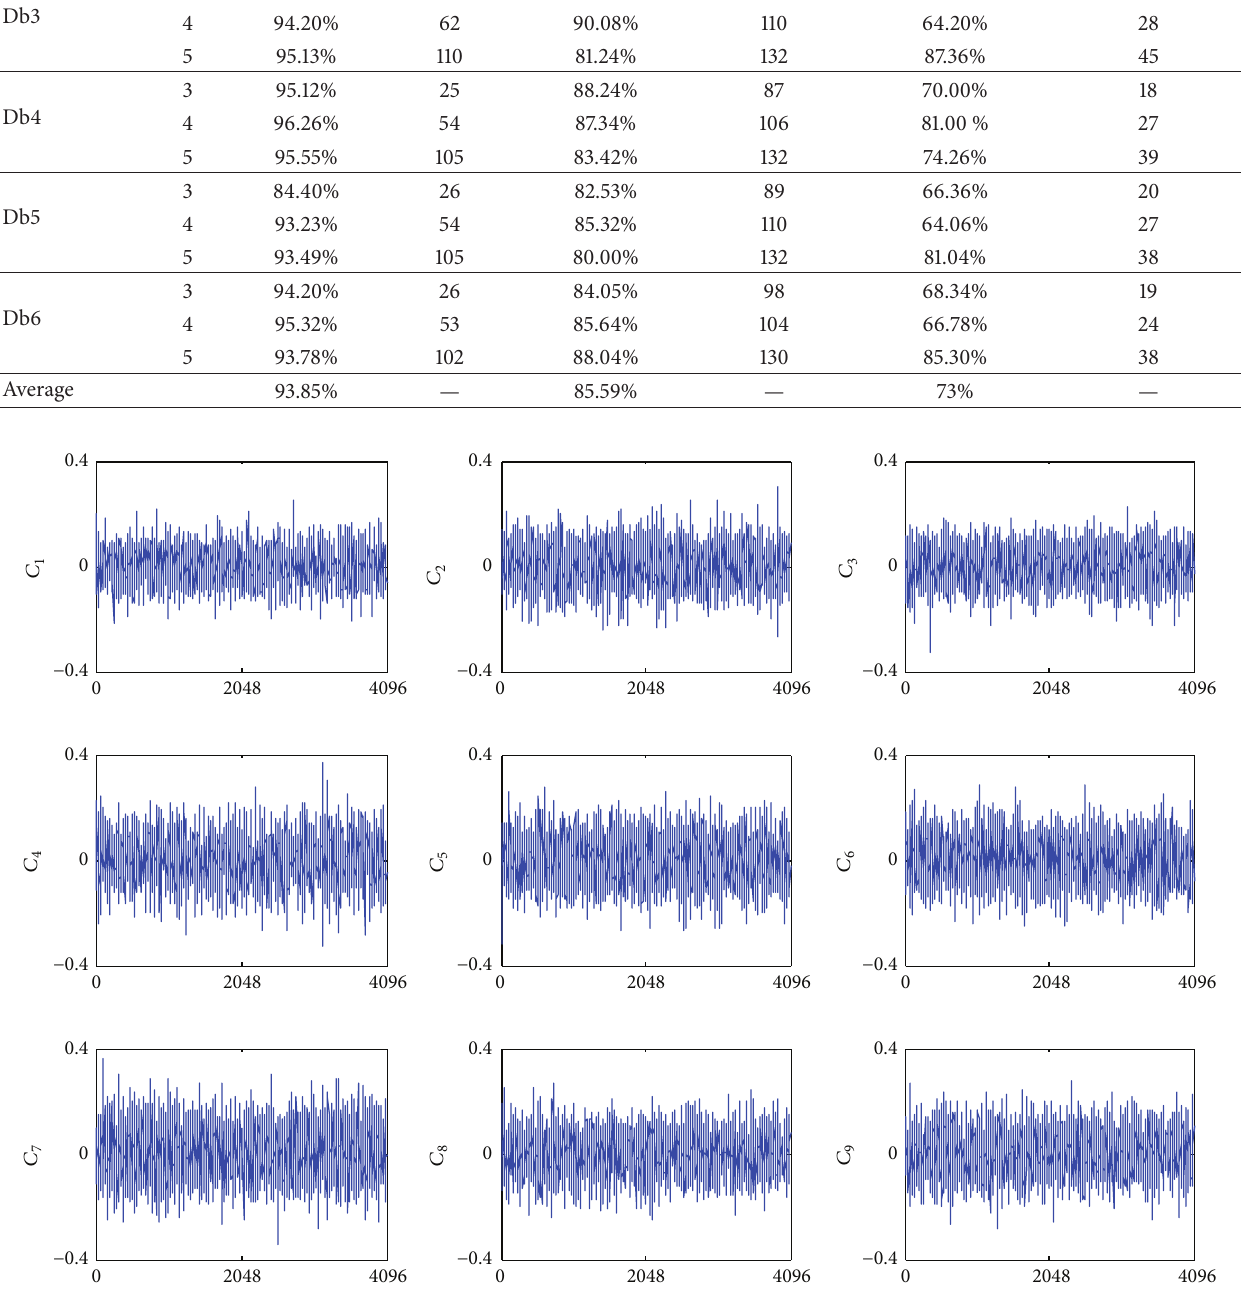
Figure 6: Examples of vibration signal at ninth